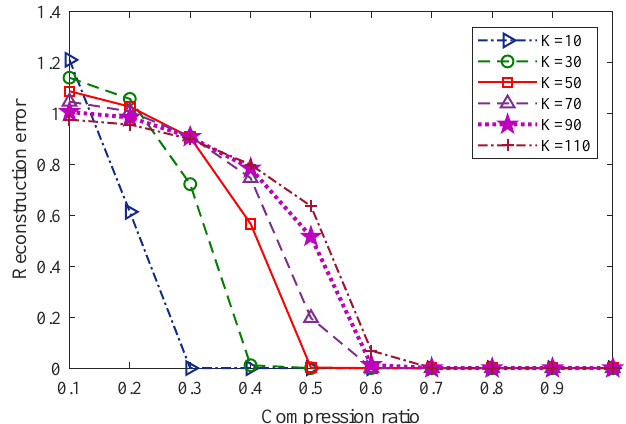
Figure 10. The relationship between the reconstruction error and the compression ratio for different gas signals with different sparseness degrees using the TVS ‐ MH algorithm.